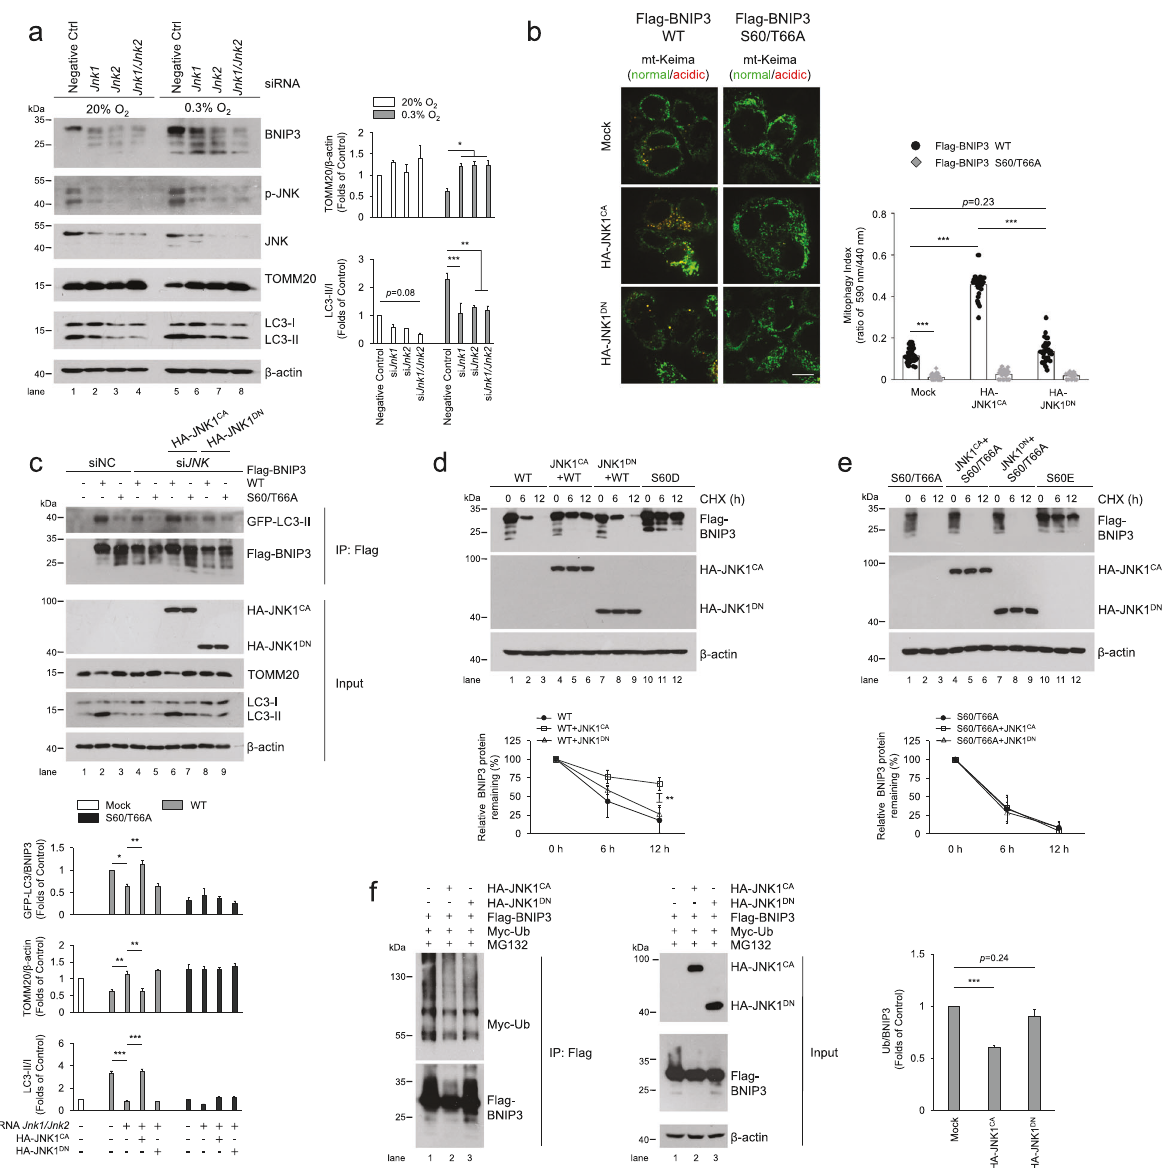
Fig. 6 Phosphorylation of BNIP3 at S60/T66 by JNK enhances mitophagy and impedes BNIP3 proteasomal degradation. a PC12 cells were transfected with negative control (NC), Jnk1 and Jnk2 siRNA for 48 h and then exposed to 20% O 2 or 0.3% O 2 for 6 h, and cell lysates were subjected to western blot analysis with the indicated antibodies. n = 3. b HeLa Cells stably expressing mt-Keima were co-transfected with plasmids encoding constitutively active (CA) or dominant negative (DN) HA-JNK1 and Flag-BNIP3 WT or S60/T666A, and mitophagy was identi fi ed and quanti fi ed by the ratio of acidic (590 nm, red) to normal mitochondria (440 nm, green). Scale bar, 10 μ m. n ≧ 30. c HeLa cells were transfected with NC or JNK1 and JNK2 siRNA and plasmids encoding GFP-LC3. After 48 h, the cells were transfected with plasmids encoding wild-type (WT) or S60/66 A Flag-BNIP3 and HA-JNK1 CA or HA-JNK1 DN for an additional 24 h. Cell lysates were immunoprecipitated with an anti-Flag antibody and examined via western blotting with the indicated antibodies. n = 3. d , e HeLa cells were co-transfected with constitutively active or dominant negative HA-JNK1 and BNIP3 WT ( d , left) or the S60/T66A mutants ( e , right). After transfection for 48 h, 20 μ g ml − 1 CHX was added to the cultures for the indicated time, and the degradation of BNIP3 was detected via western blotting with the indicated antibodies and quanti fi ed, respectively. f HeLa cells were co-transfected with Flag-BNIP3, Myc-Ub and constitutively active or dominant negative HA-JNK1 for 48 h, and 10 μ M MG132 was added 12 h before samples were collected. Cell lysates were boiled and immunoprecipitated with an anti-Flag antibody. The immune complexes were then analyzed via western blotting. n = 3. The data are expressed as means ± SEM. * P < 0.05, ** P < 0.01, *** P < 0.001 versus the indicated group. BNIP3-mediated mitophagy. We co-transfected HeLa cells with catalytic subunits of PP1 or PP2A were knocked down at the same PPP1CA or PPP1CC (two main catalytic subunits of PP1) combined time, the effect of PP1 or PP2A knockdown was manifested, in with BNIP3 plasmids and observed the effect of PPP1CA/C on other words, inhibition of PP1 or PP2A expression increased the BNIP3 phosphorylation and the interaction between them using a level of BNIP3 phosphorylation after cells were exposed to hypoxia co-IP assay. As expected, PPP1CA/C caused remarkable depho- instead of normoxia (Fig. 4b). In addition, we also noticed that the sphorylation of BNIP3 when PPP1CA/C was overexpressed in cells. role of PP1 is slightly stronger than PP2A. Therefore, we focused In the meantime, when BNIP3 was immunoprecipitated with a on determining whether PP1 interacts with BNIP3 and affects Cell Death and Disease (2022)